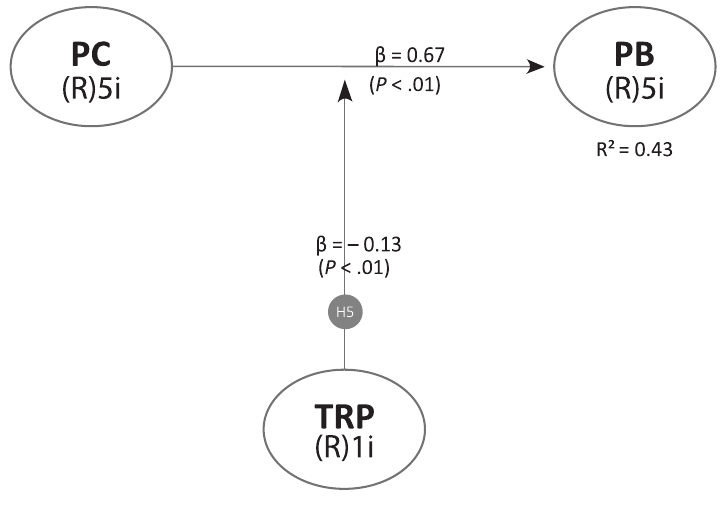
Figure 3. TRP as